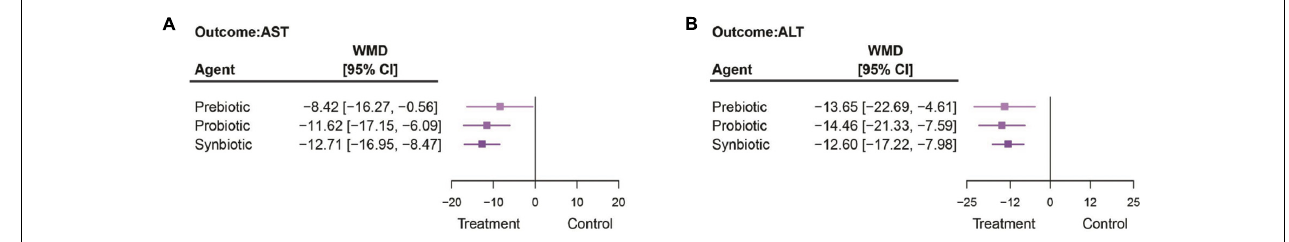
FIGURE 3 | The summarized results of using synbiotics, probiotics, and prebiotics for the reduction in (A) AST and (B) ALT.